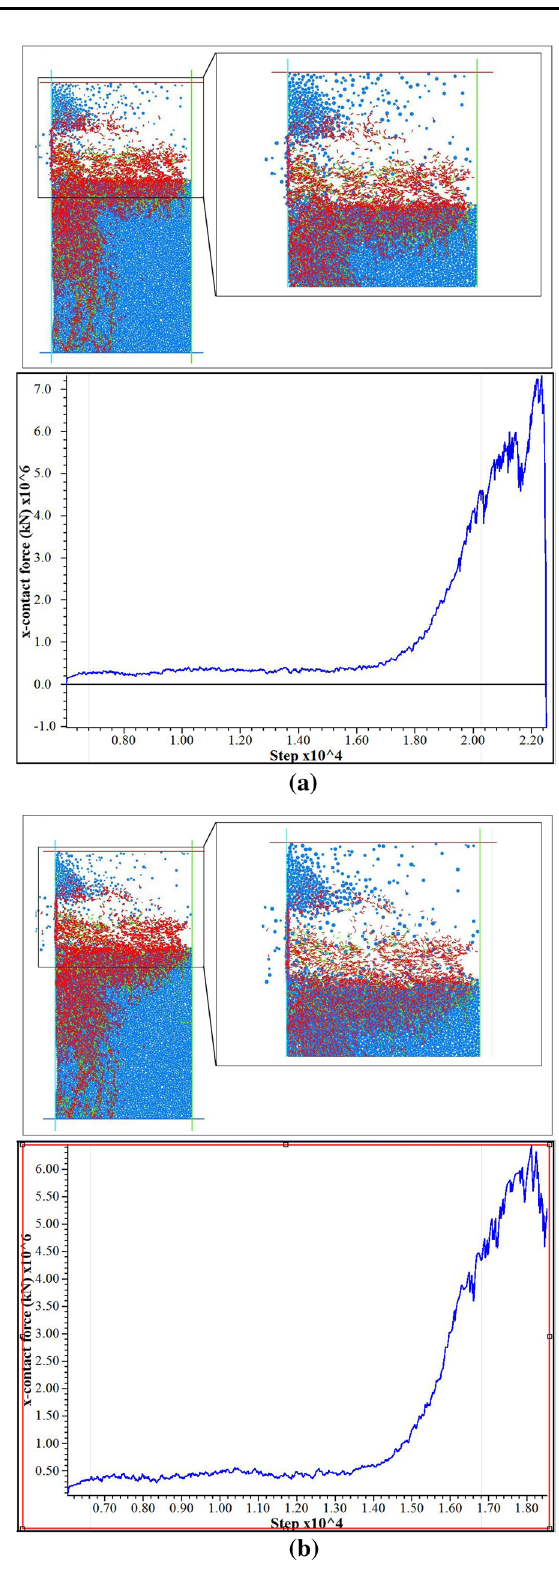
Fig. 20 Results of plow model with zero-degree angle: a Model 27, b Model